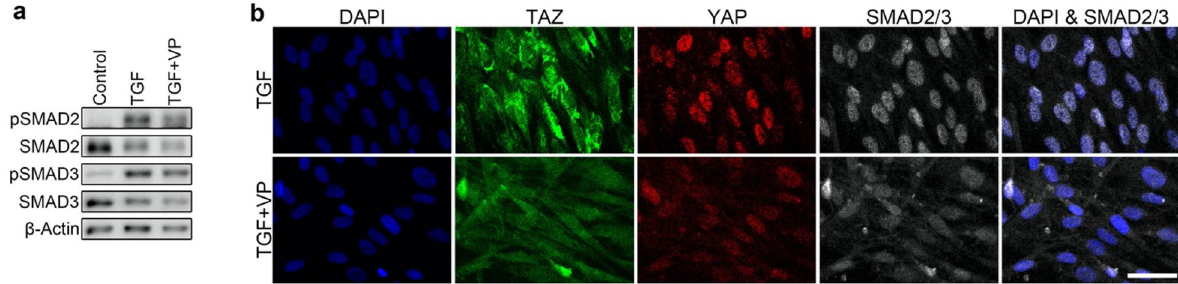
Figure 8. Verteporfin inhibited TGF-β1-induced SMAD2/3 nuclear accumulation without interfering with phosphorylation of SMAD2/3. HVOX fibroblasts were treated with or without 10 ng/mL TGF-β1 and 3 µM verteporfin (VP) for 24 h. Western blotting was performed to detect Ser465/467-phosphorylated SMAD2 (pSMAD2), SMAD2, Ser423/425-phosphorylated SMAD3 (pSMAD3), SMAD3, and β-actin in the total cell fraction ( a ; representative grouping of gels cropped from different parts of the same gel or from different gels; whole gels available in supplemental material). Nuclear localization of YAP/TAZ and SMAD2/3 were examined by immunostaining ( b ; bar = 100